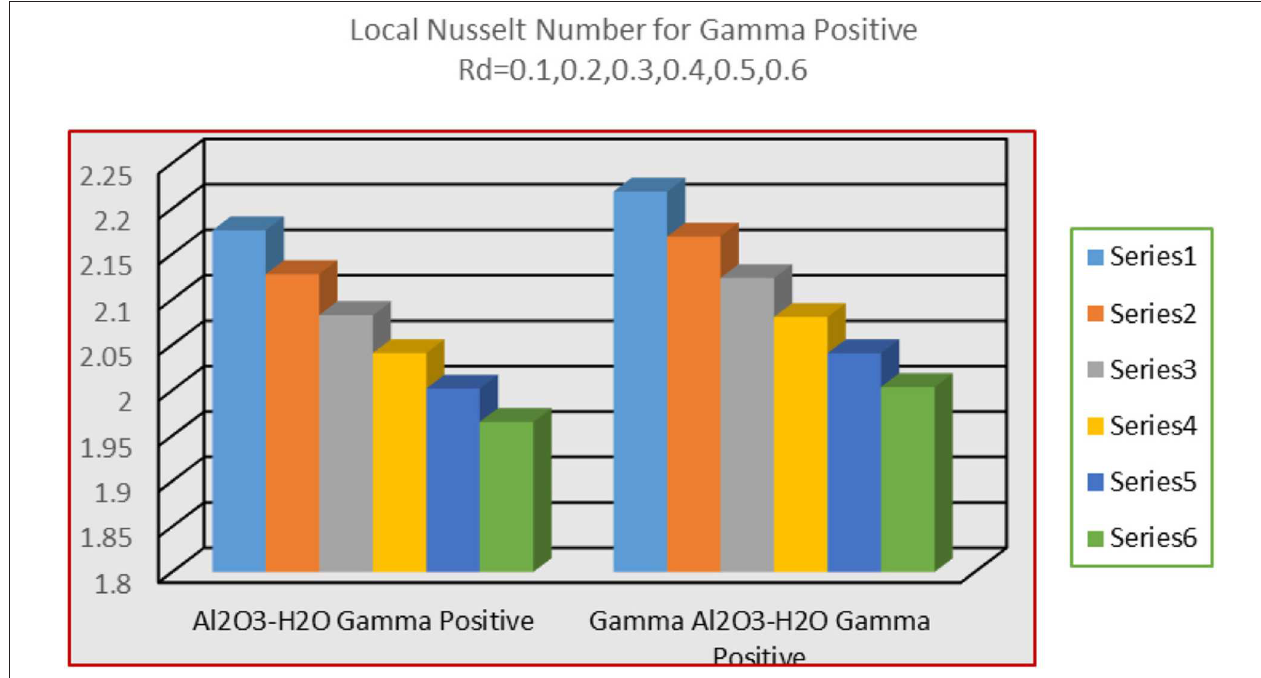
FIGURE 13 | The effects of Rd on local Nusselt number ( γ > 0).